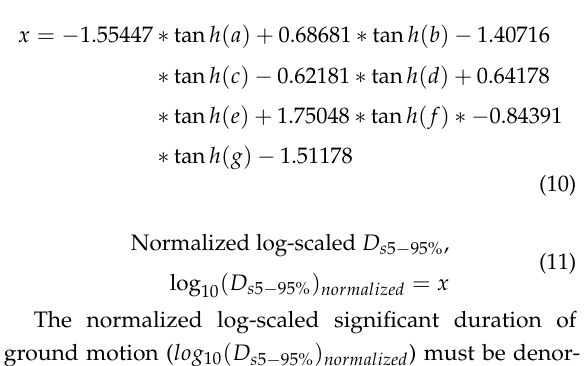
x = − 1.55447 ∗ tan h ( a ) + 0.68681 ∗ tan h ( b ) −